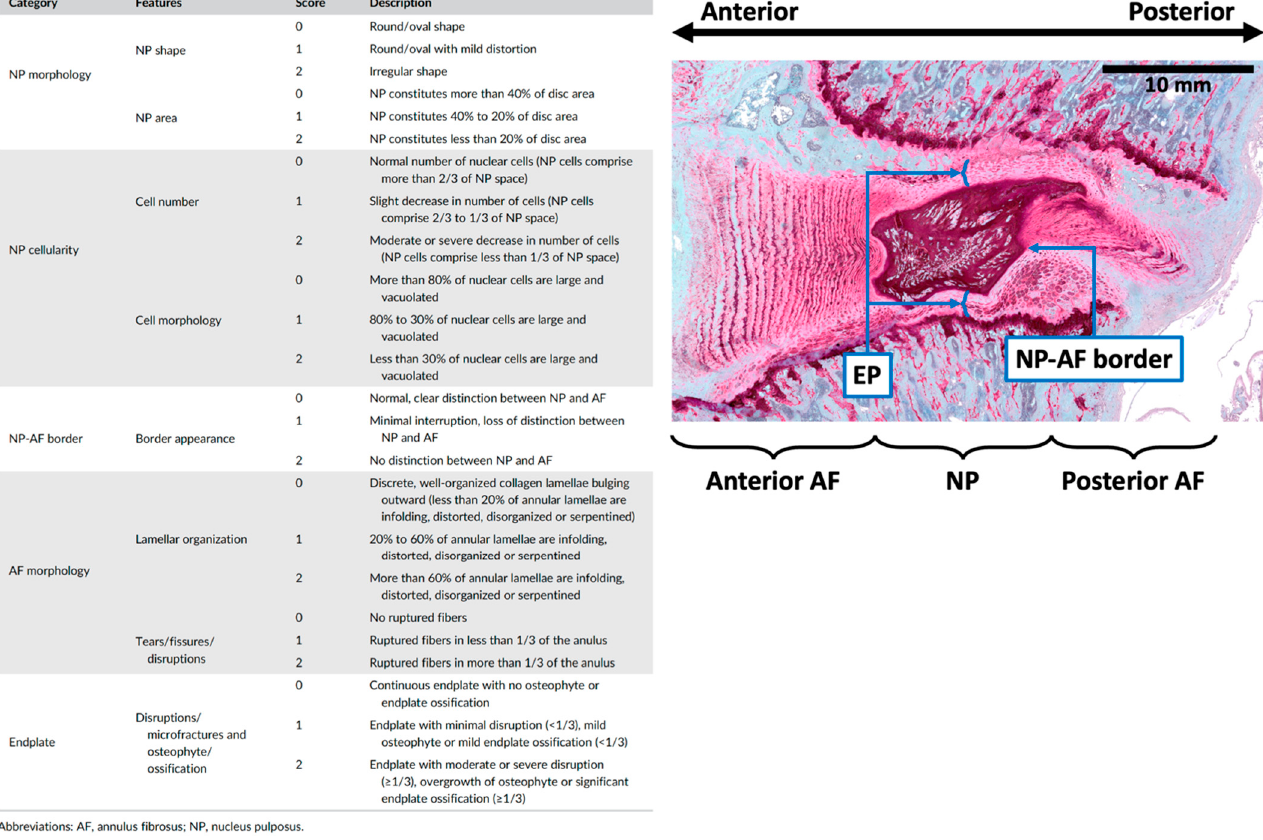
Figure 9. Degeneration grading system with five sub-categories for quantifying the severity of rat IVD degeneration (adopted from Lai et al. JOR Spine 2021 [26]). Rat IVD, with safranin-O/Fast- green/Hematoxylin staining indicating different IVD regions for IVD degeneration quantification.